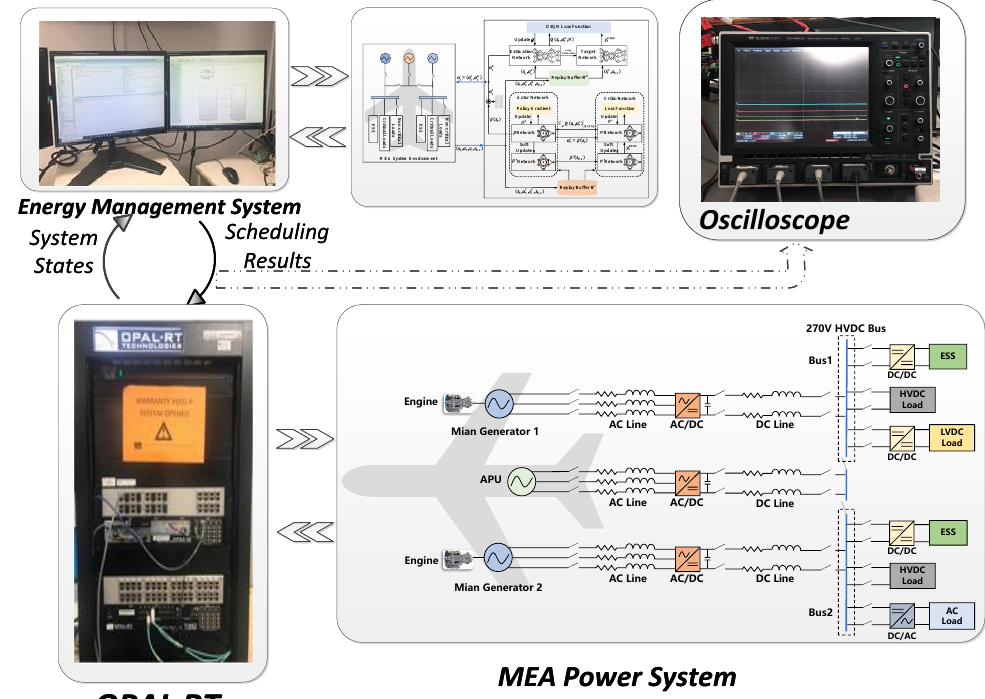
Figure 11. Hardware-in-the-Loop test for the proposed approach.